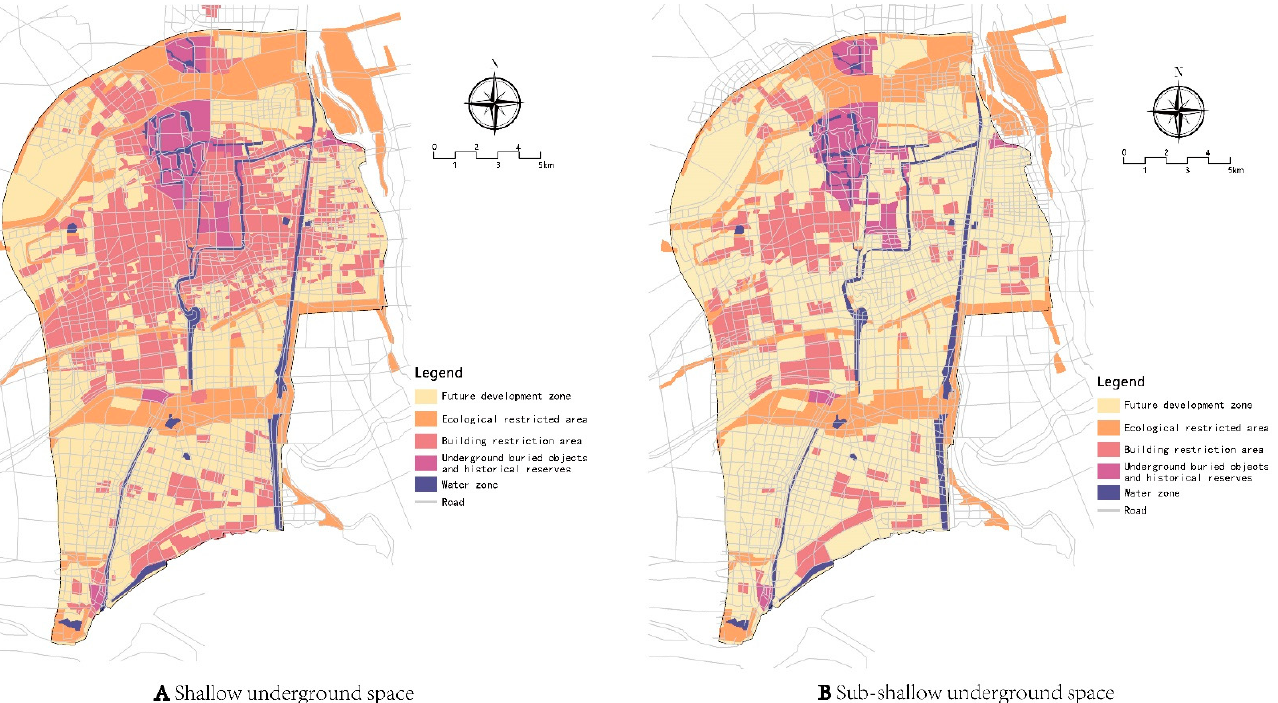
Figure 12. The Existing USR of Yangzhou city.